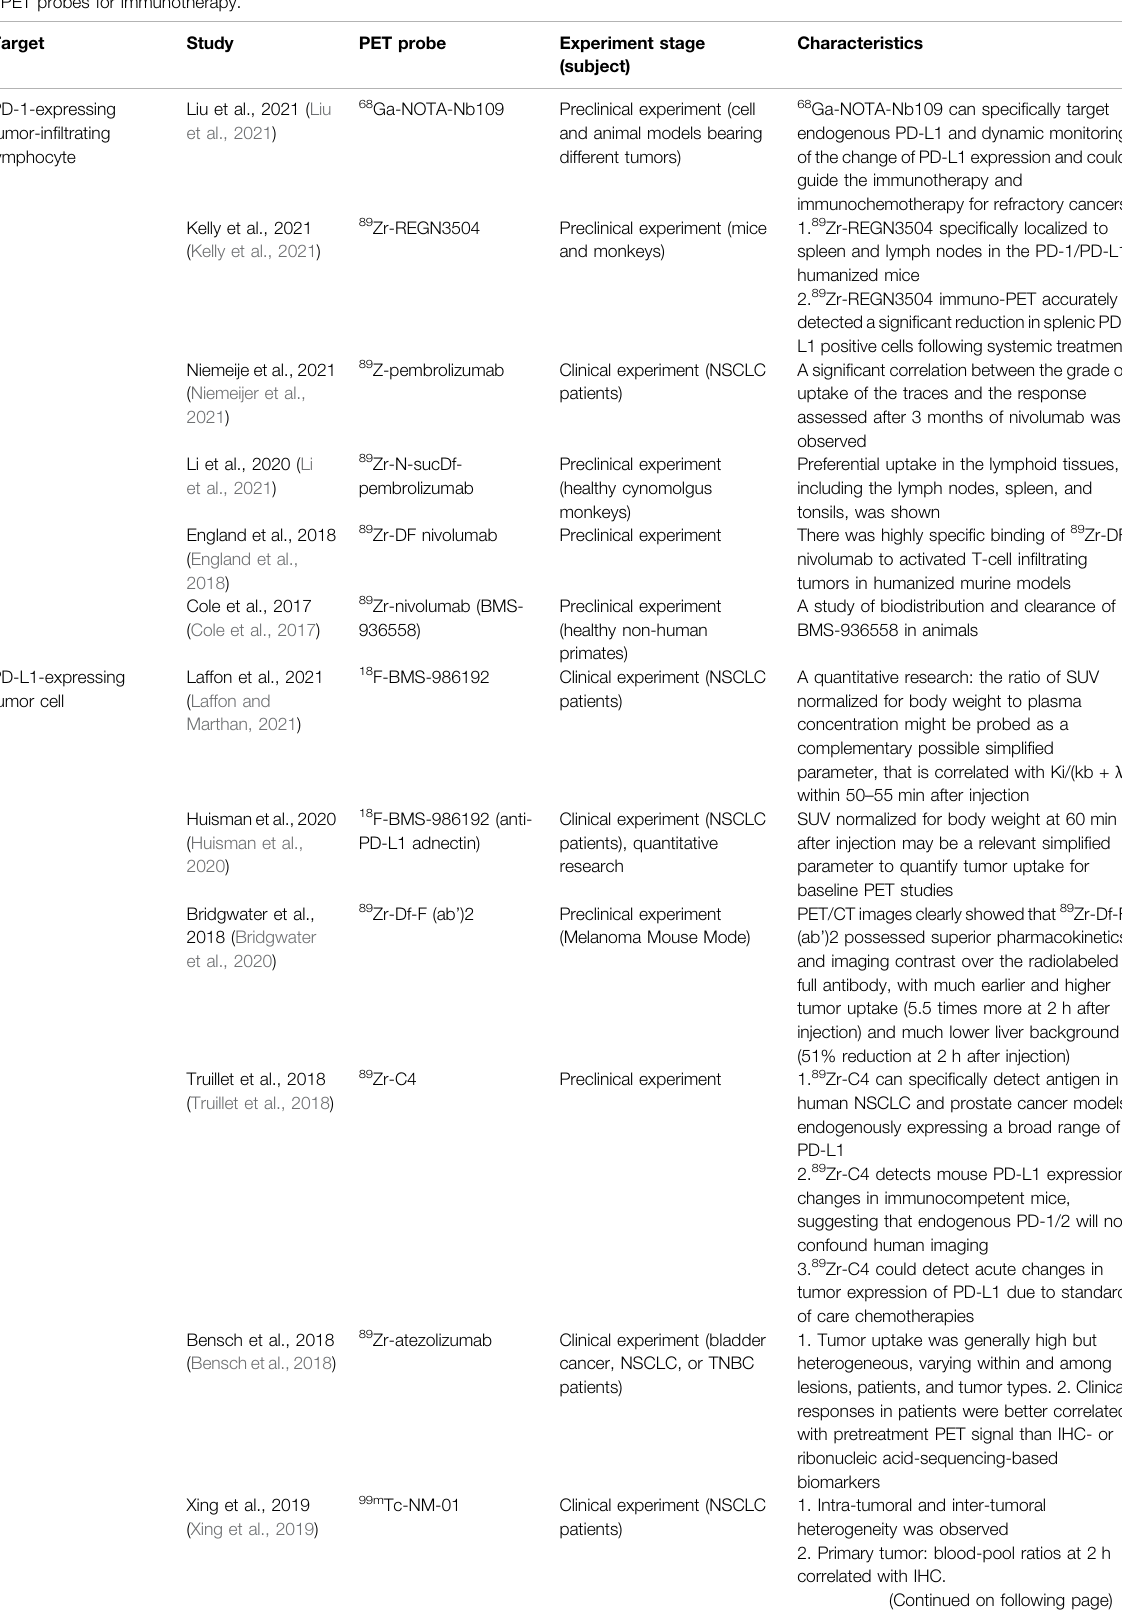
TABLE 4 | Novel PET probes for